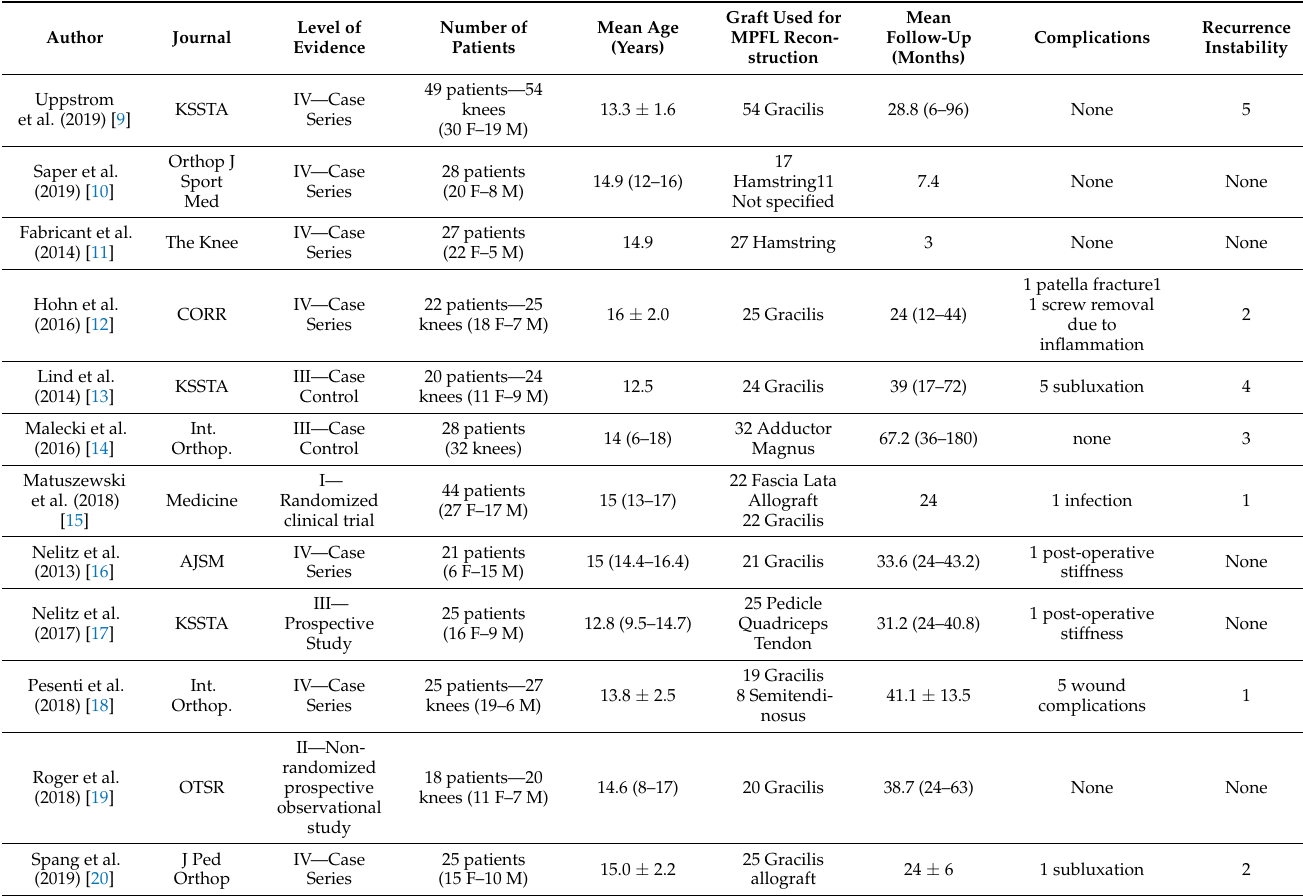
Table 1. Demographic characteristics of the selected